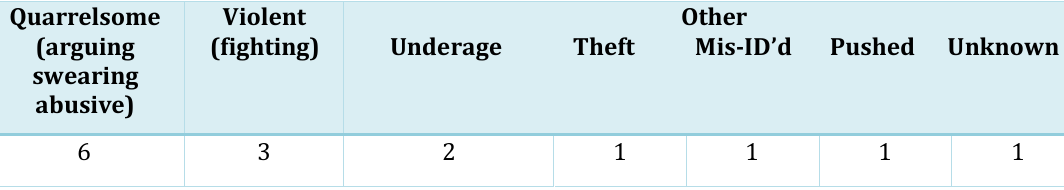
Table 2: Reported Licensee Barring Order Imposition Reasons Quarrelsome (arguing swearing